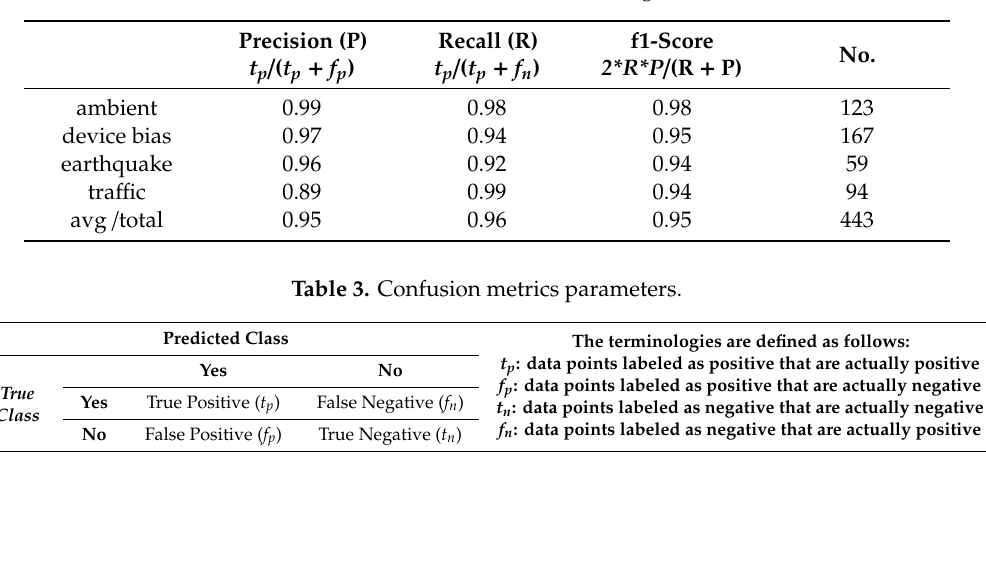
Figure 7. Confusion matrix for CNN model with original dataset. Table 2. Precision, recall, and f1-score for original dataset.